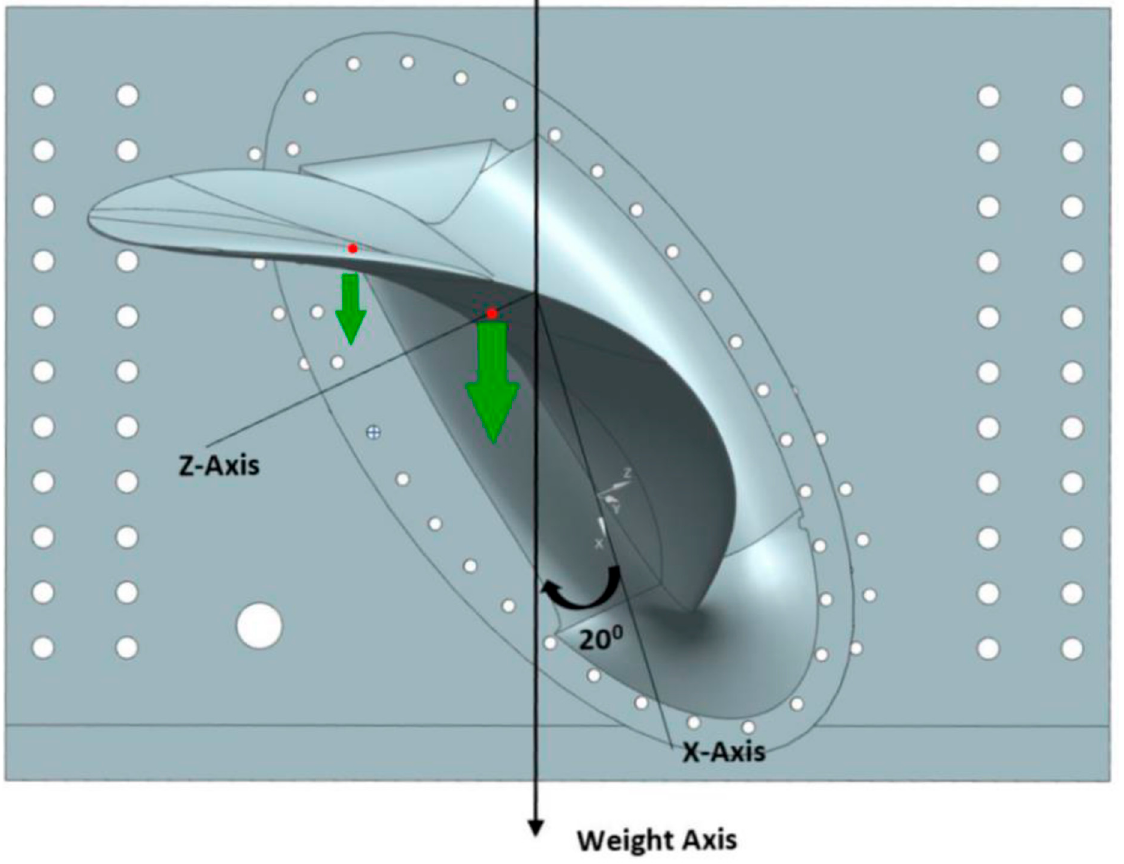
Figure 4. The setup of the experiment in a CAD model. The prototype is mounted to a steel test rig. The red dots indicate the loading points. Figure from [9].